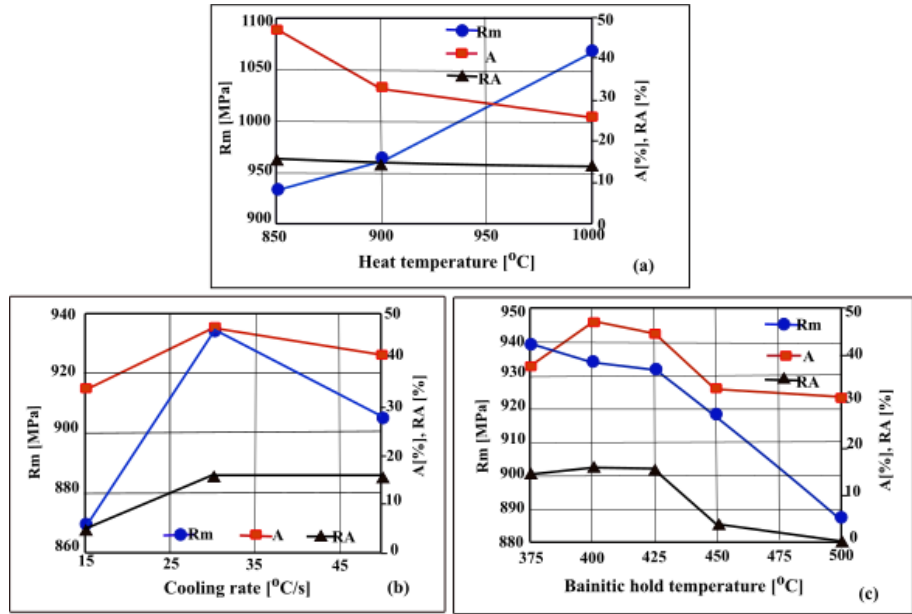
Figure 14: The effect of; (a) heating temperature, (b) cooling rate, and (c) bainitic phase temperature. Reprinted with permission from Kucerova // Metals 7 (2017). ©2017 Licensee MDPI, Basel, Switzerland.